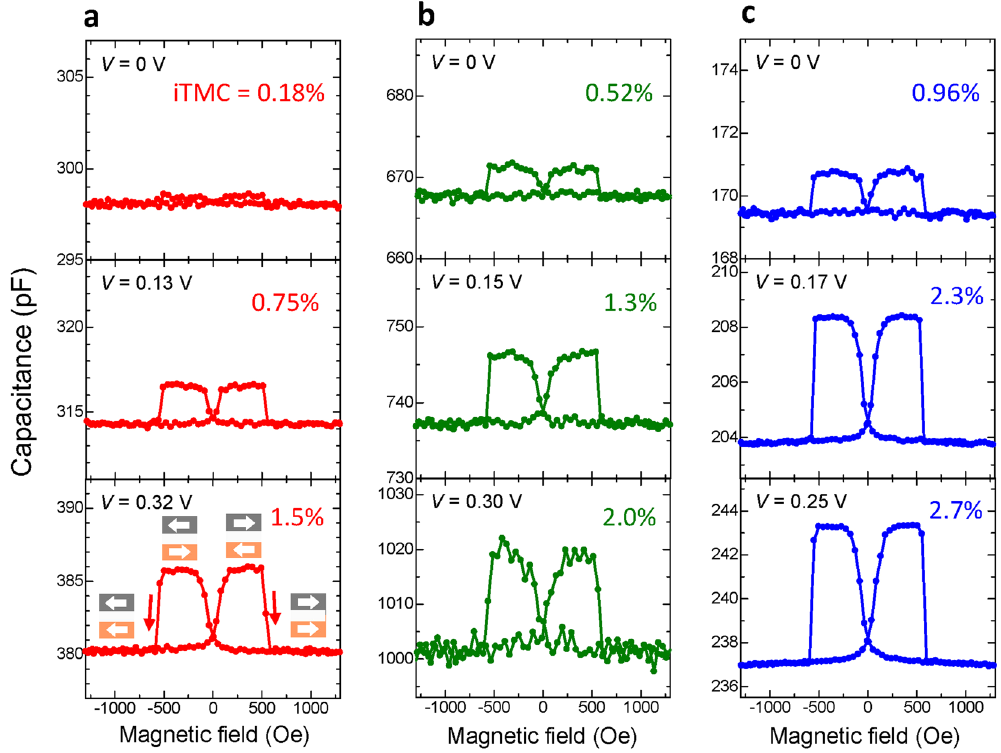
Figure 3. Observation of the inverse TMC. Inverse TMC effect of ( a ) sample A ( f = 10 kHz), ( b ) sample B ( f = 12 kHz) and ( c ) sample C ( f = 12 kHz) at room temperature. The iTMR ratios of samples A, B and C are 1%, 7% and 15%, respectively, which are measured by a dc four probe